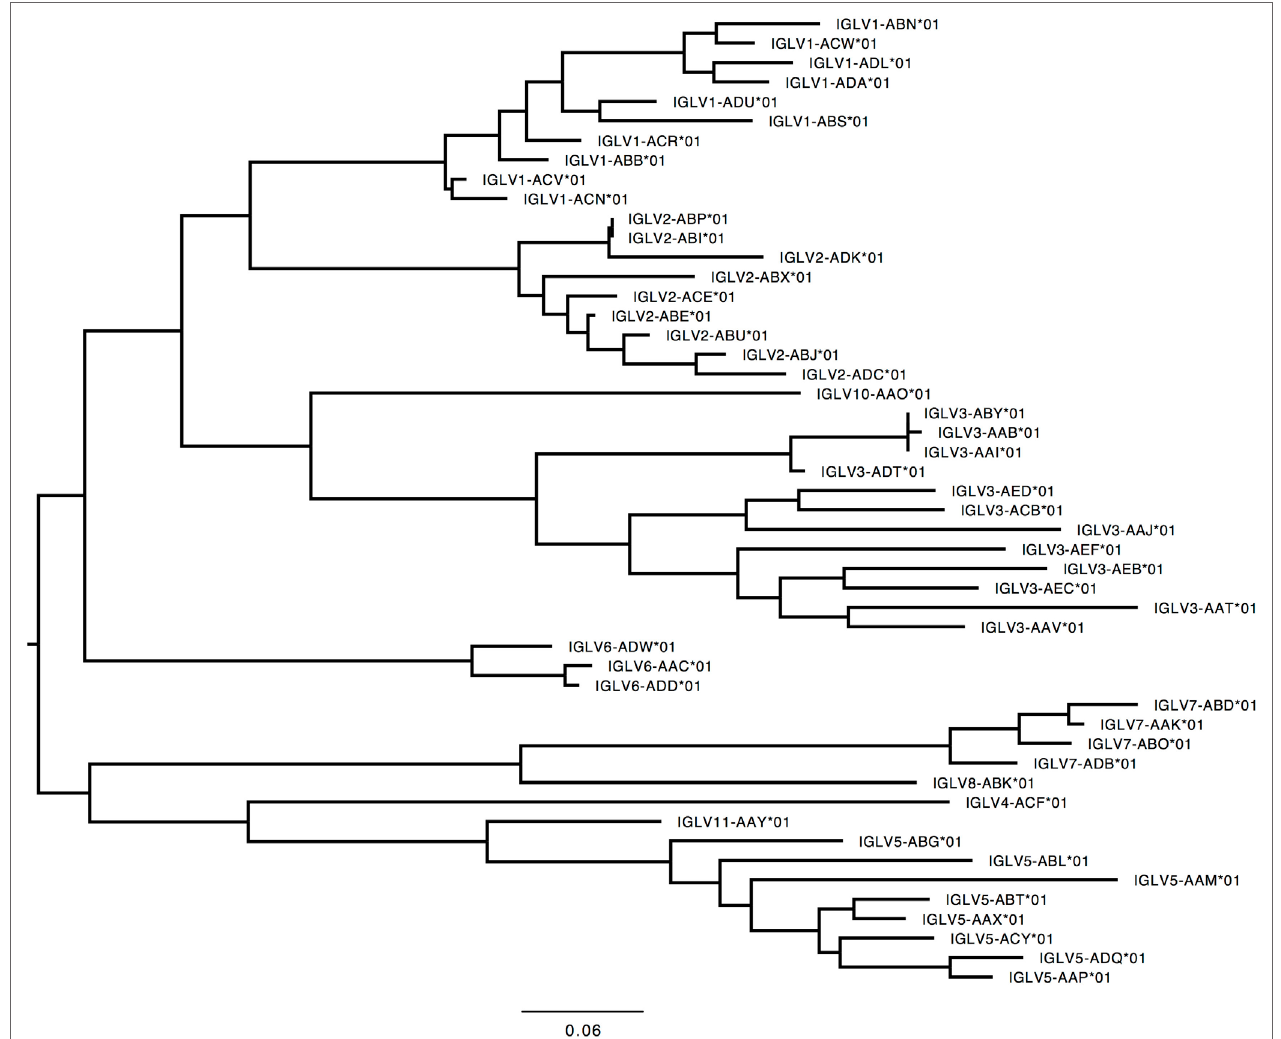
FigUre 6 | Maximum likelihood phylogenetic tree of the rhesus IGLV functional genes, based on the final immunoglobulin allele library.